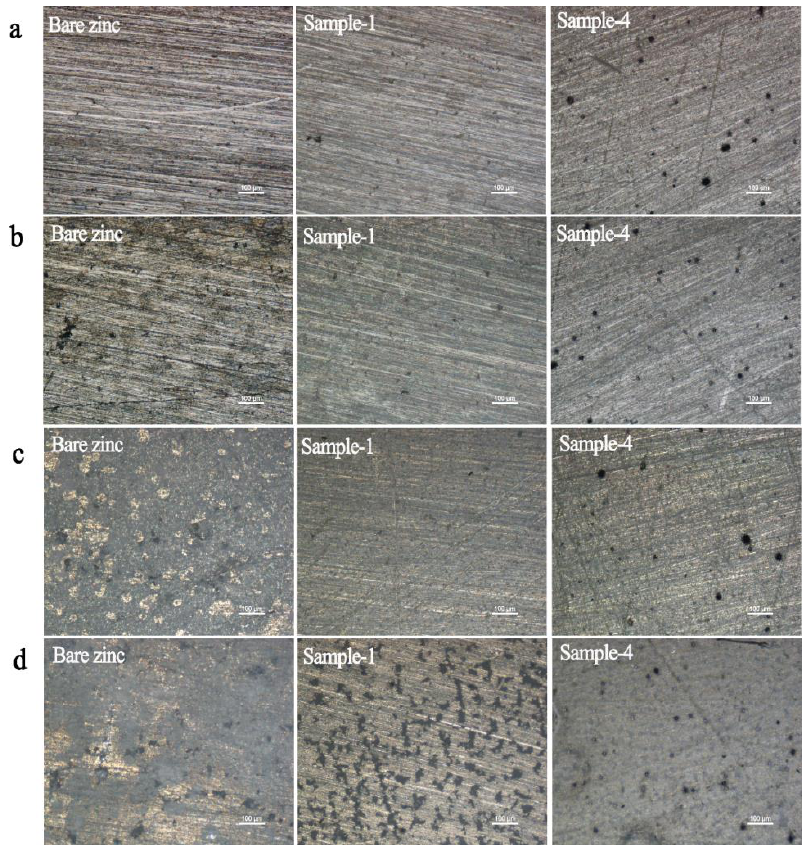
Figure 8. Photograph of bare zinc, PVB coated zinc (Sample 1) and PVB blended with 1.9 wt.% PNVPY and 2.3 wt.% CB coated zinc (Sample 4) in different immersion times ( a ) 0 h ( b ) 24 h ( c ) 48 h ( d ) 168 h. The specimens were tested in 3.5% NaCl solution at room temperature (25 °C).